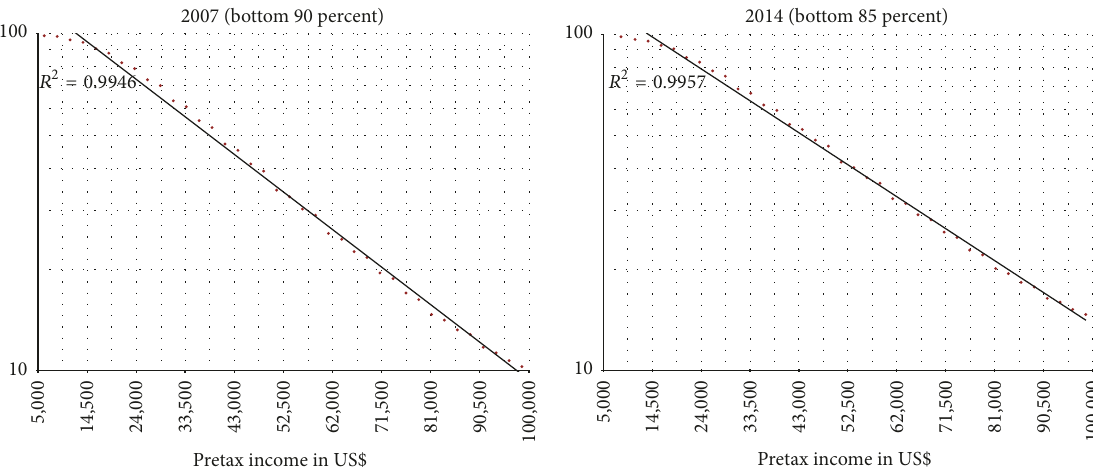
Figure 2: Semilog inverse or counter-cumulative distributions of income in US, exponential fits (linear in this space), and their 𝑅 2 . Bottom 90 percent of surveyed households for 2007 and bottom 85 percent for 2014. Calculated from US Census Bureau data.